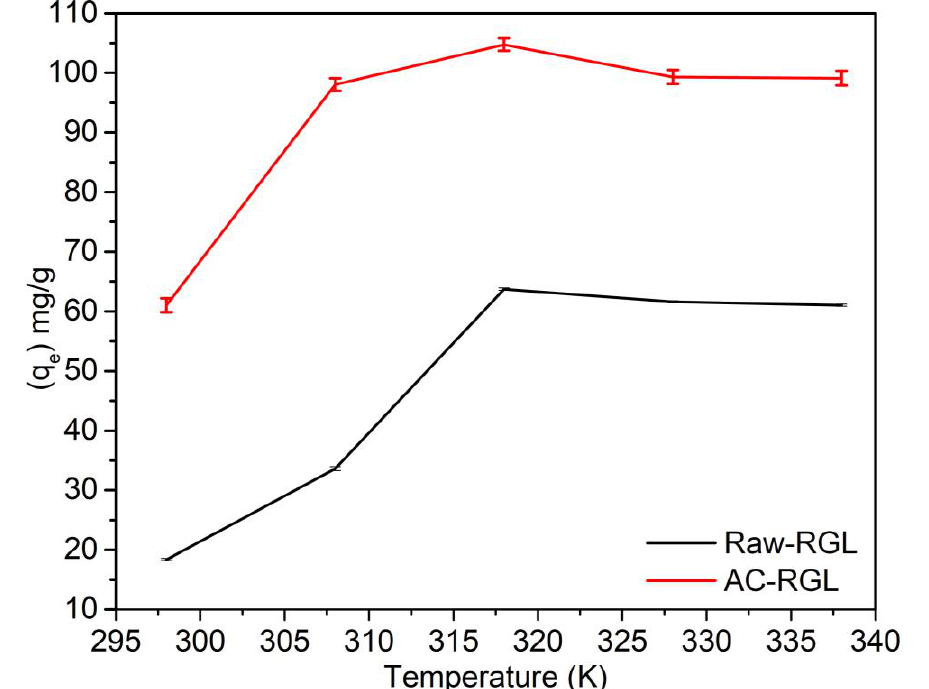
Figure 8. Effect of temperature on ibuprofen uptake by Raw-RGL and AC-RGL adsorbents. Thermodynamic parameters are vital for investigating heat variation and the spon- taneity of the sorption process [57]. ΔG°, ΔH°, and ΔS° are calculated at different temper- atures (298; 308; 318; 328 and 338 K) of ibuprofen on Raw RGL and AC-RGL sorbents and indicated in Table 6. The ΔH° results for both adsorbents indicate that the sorption pro- cesses are exothermic. The size of ΔH° of ibuprofen adsorption suggests a weak interactive strength, which also suggests electrostatic attraction [55]. ΔS° data for ibuprofen adsorp- tion by Raw-RGL and AC-RGL indicate an increase in the randomness of ibuprofen in solution as the adsorption reaches equilibrium. The ΔG° figures for both adsorbents indi- cate that the uptake process is spontaneous and feasible. Table 6. Thermodynamic studies of Raw-RGL and AC-RGL and their parameters.